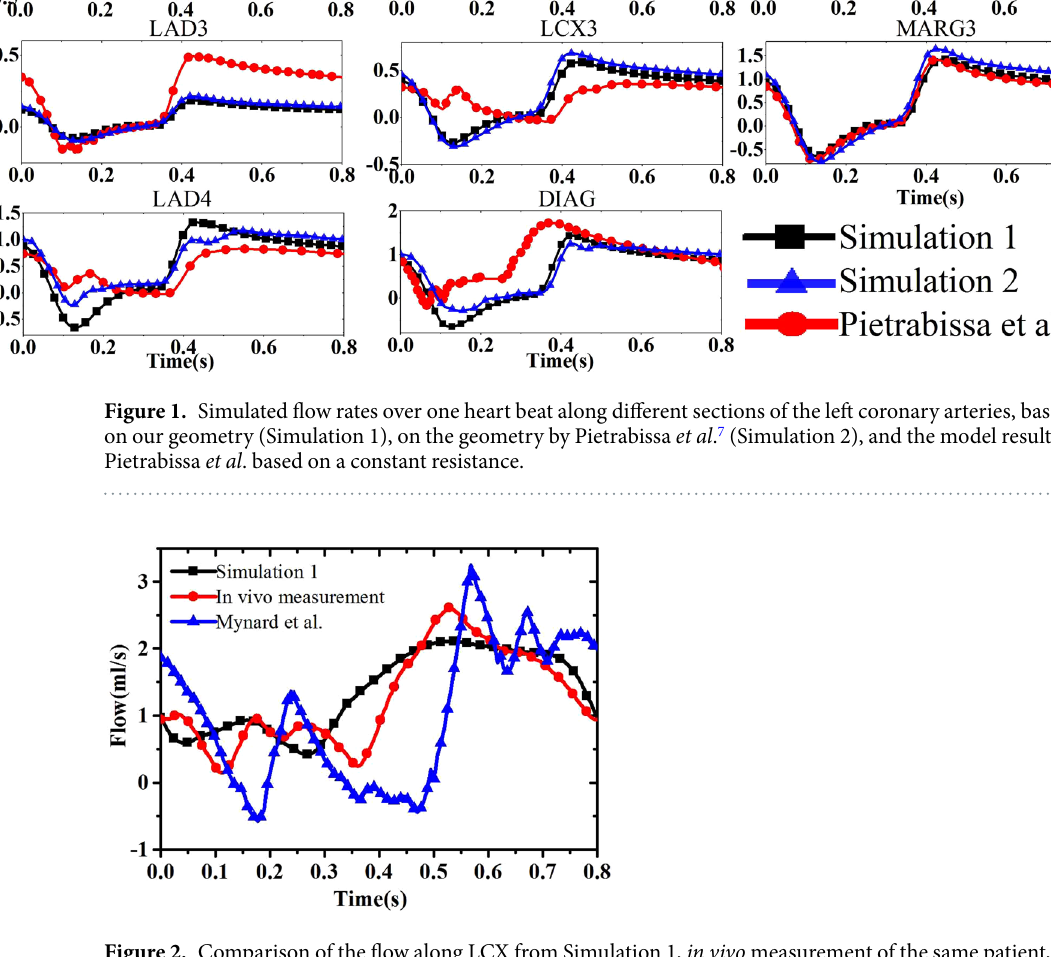
Figure 2. Comparison of the flow along LCX from Simulation 1, in vivo measurement of the same patient, and in vivo measurement of a different patient by Mynard et al . 26